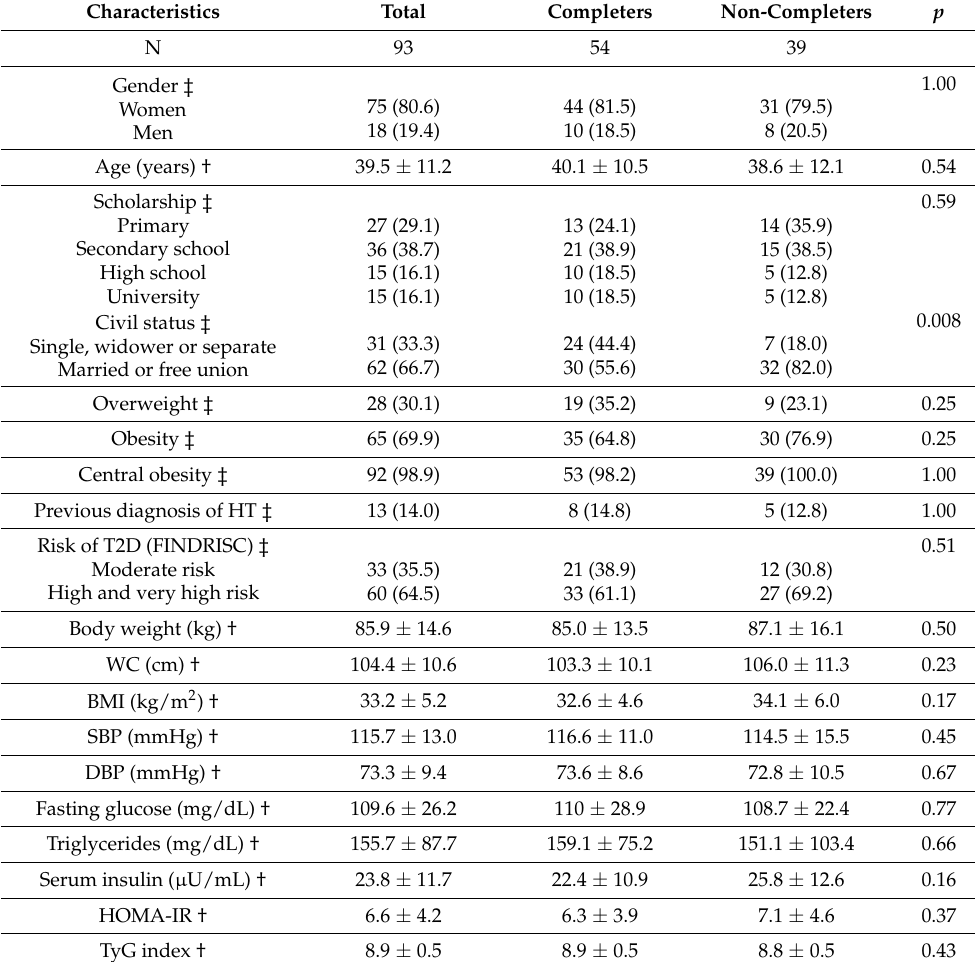
Table 1. Baseline characteristics of the